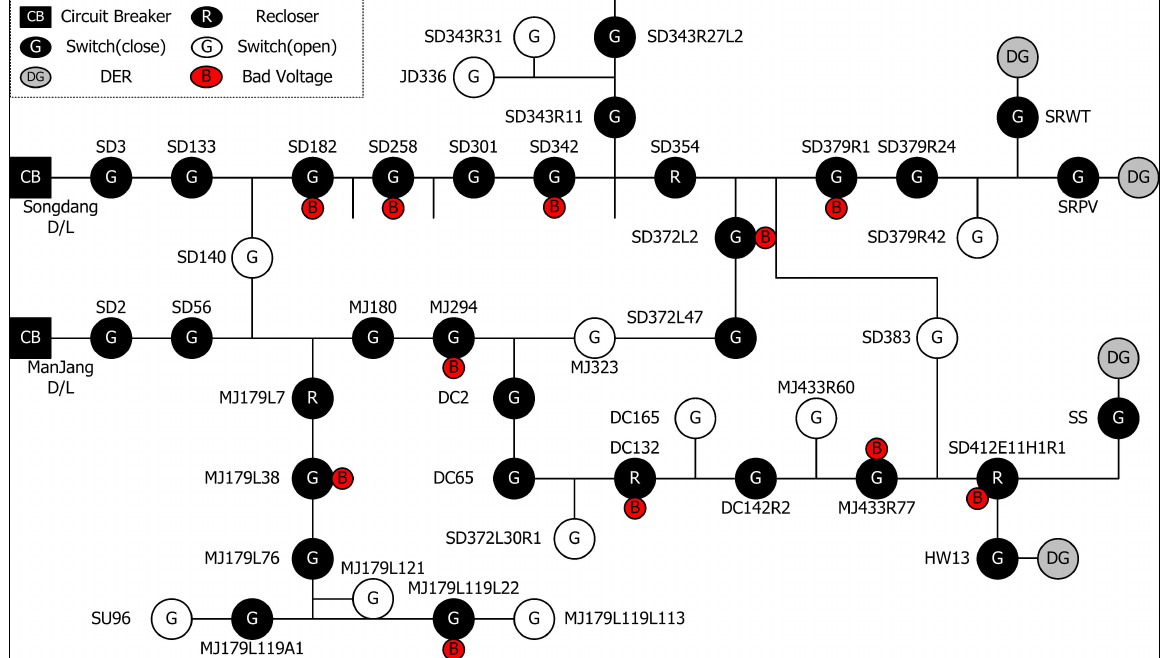
Figure 11. Test system (Jeju Songdang and Manjang D/L) for state